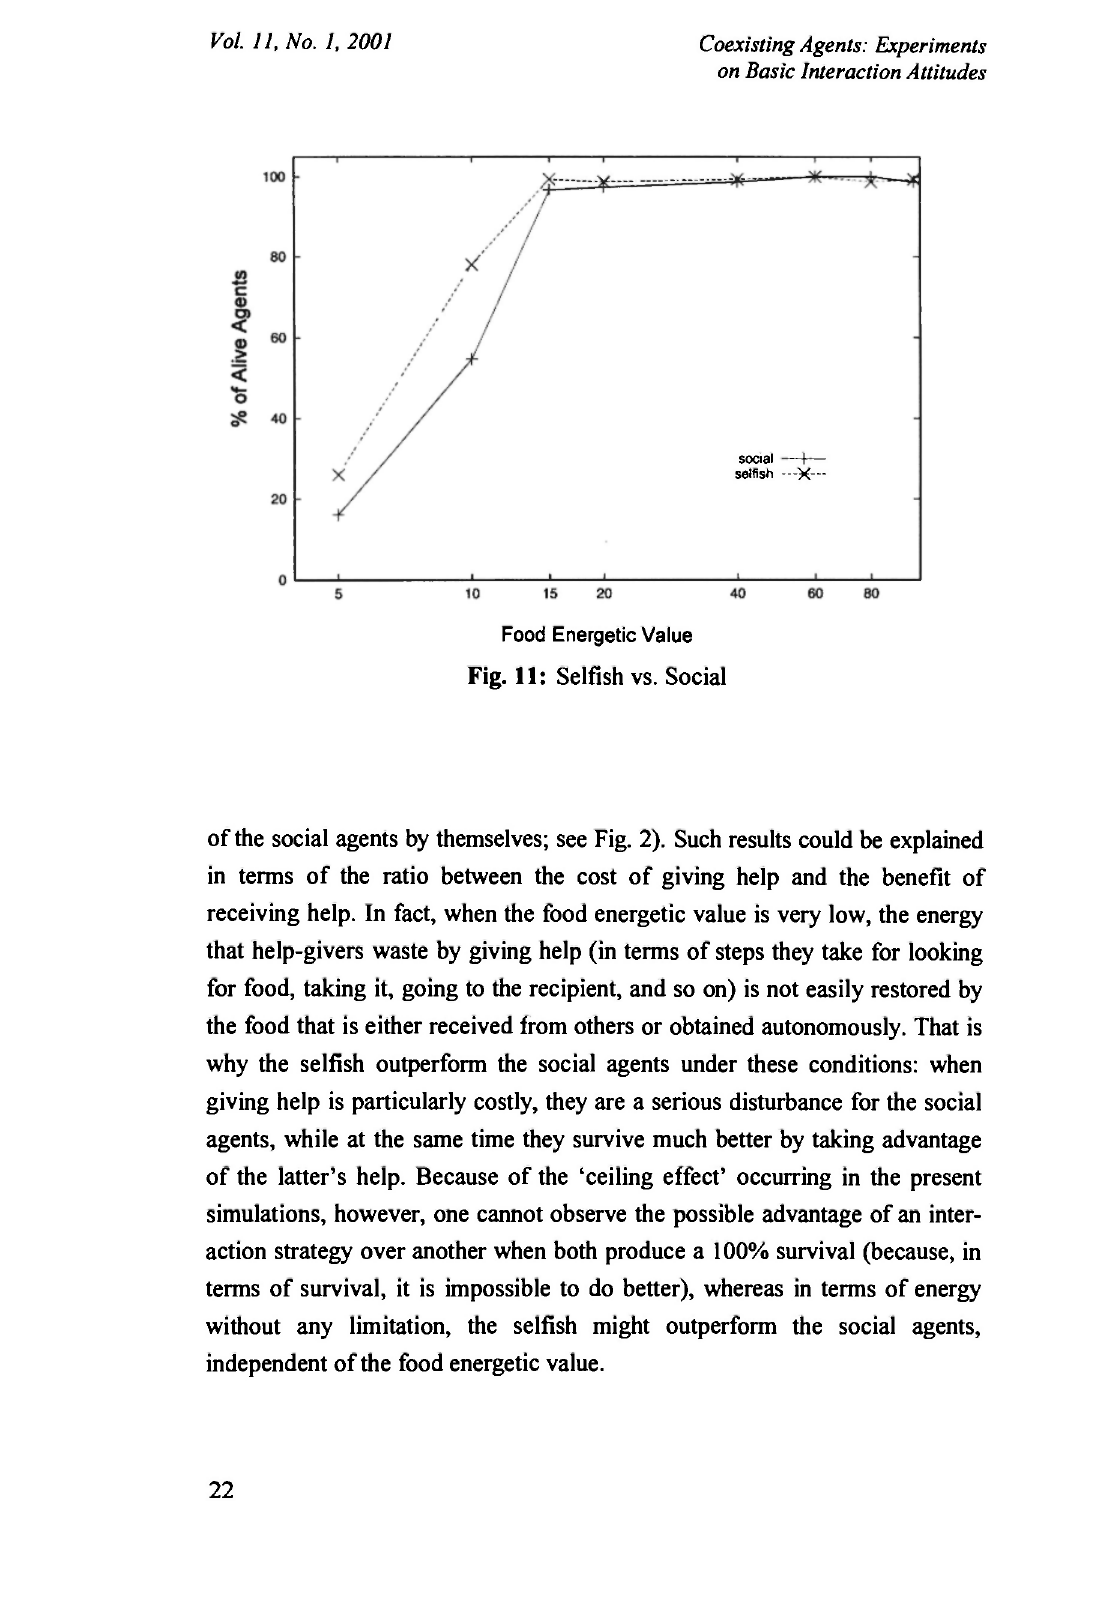
social — I— selfish